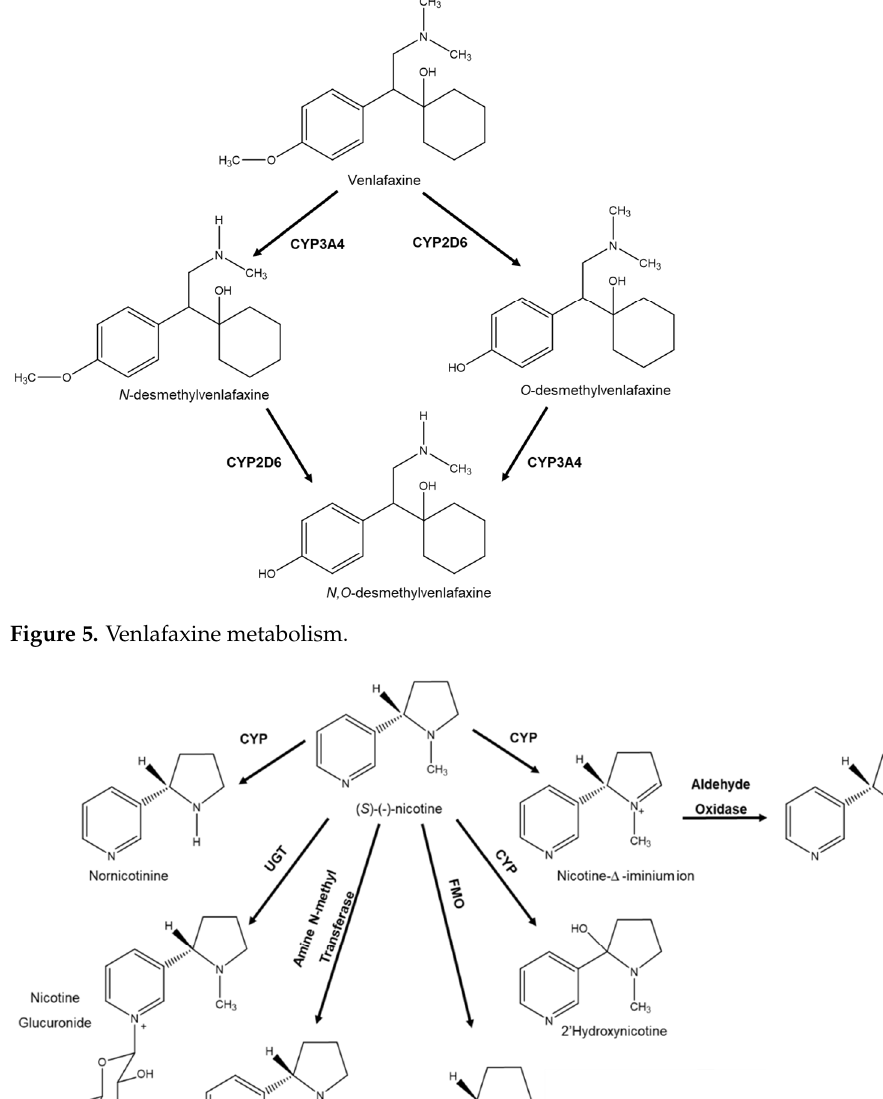
Figure 5. Venlafaxine metabolism.